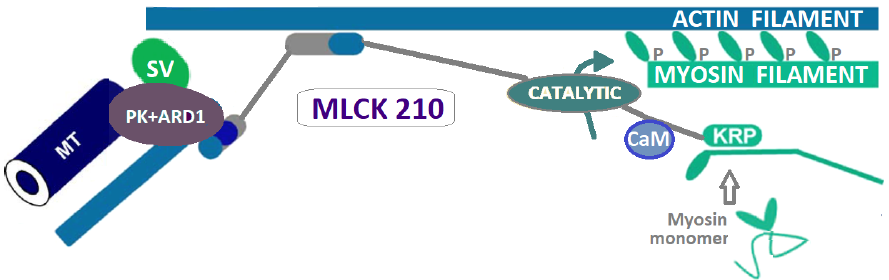
Figure 3. MLCK210 is a signal integrator molecule containing several interaction sites for cytoskeletal and regulatory proteins (based on [44,45]). Adapted with permission from Ref. [44], Shirinsky, V.P.